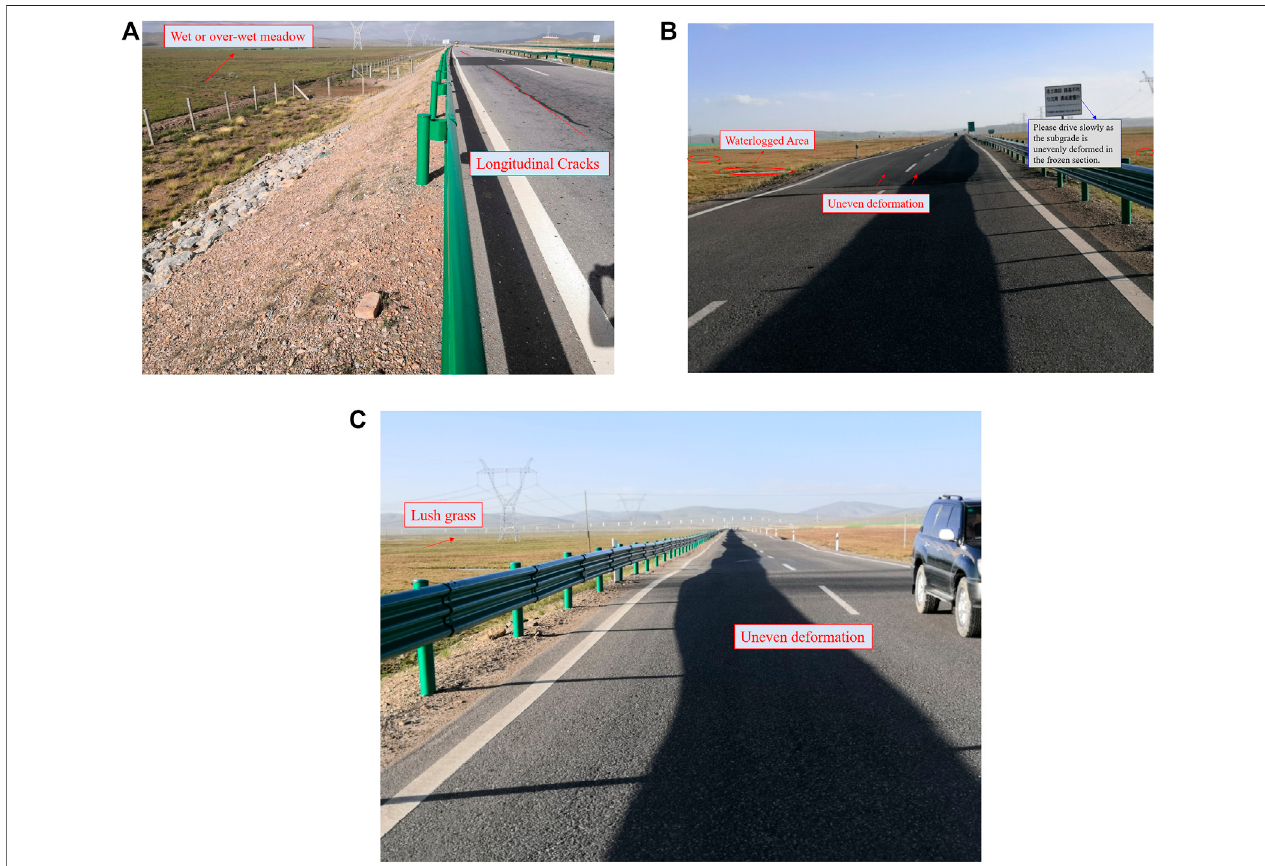
FIGURE 3 | Diseases of the road in the permafrost wetland area. (A) Longitudinal cracks. (B) Uneven deformation in frozen section. (C) Uneven deformation in developed meadow areas.